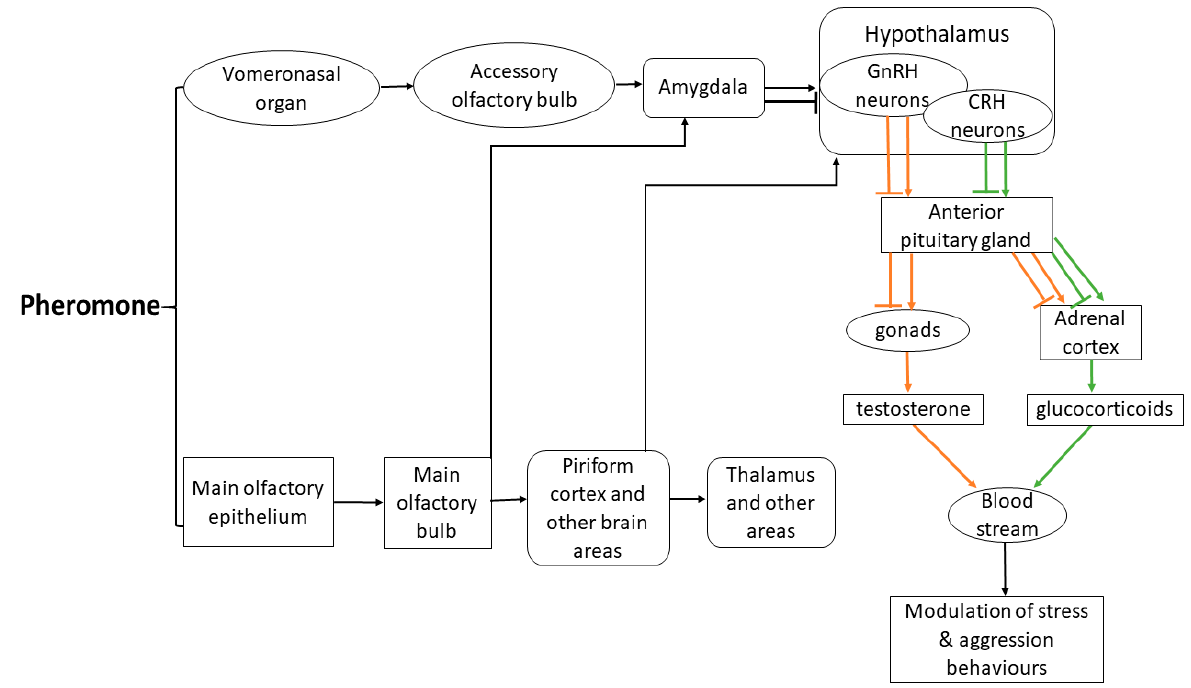
Figure 2. Pheromone perception pathways from the main olfactory epithelium and vomeronasal organ, through the main and accessory olfactory systems, and thalamic and hypothalamic higher brain regions, ultimately leading to a hormonal and/or behavioural response. Stress pathway upregulation (green ↓ ) or suppression (green ⊥ ); aggression pathway upregulation (orange ↓ ) or suppression (orange ⊥ ). Adapted from [154].